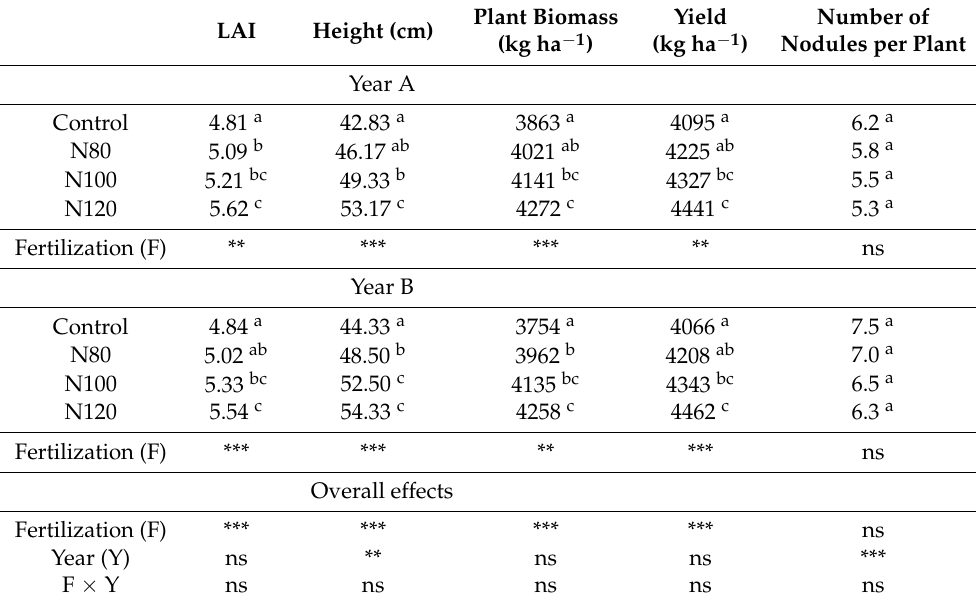
Table 3. Agronomic characteristics of soybean as affected by the different N fertilization rates. LAI Height (cm)